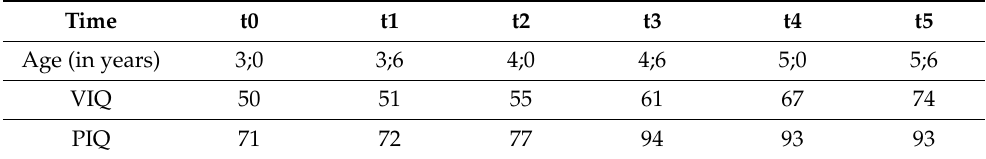
Table 1. Cognitive assessment at different time